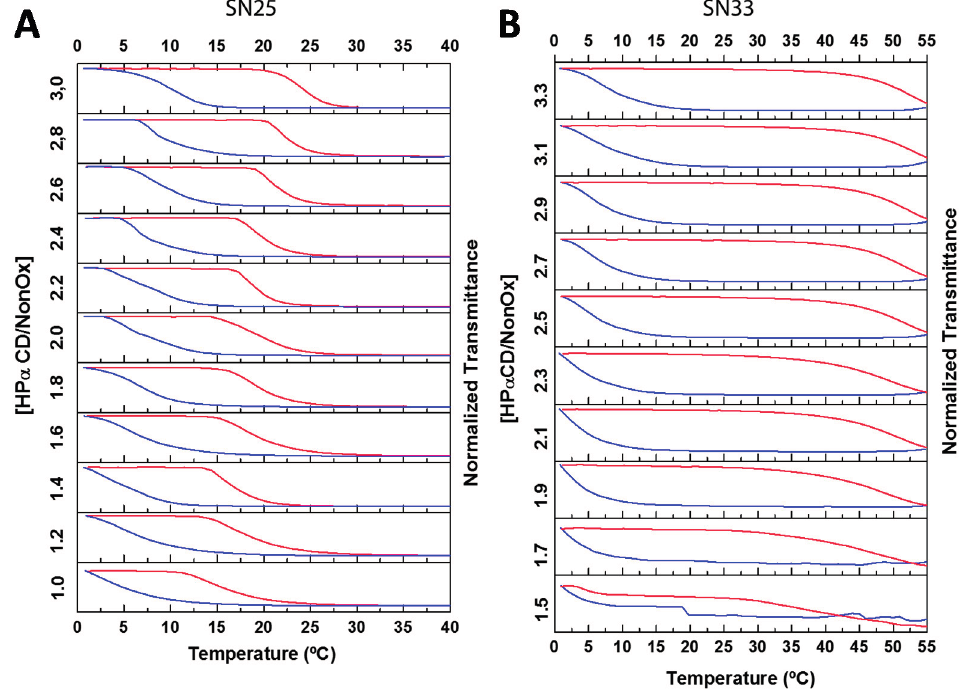
Figure 7. Turbidimetry studies of of 5 mg·mL − 1 solutions of P[(EtOx) 75 - ran -(NonOx) 25 ] ( A , SN25) and P[(EtOx) 62 - ran -(NonOx) 29 ] ( B , SN33) with increasing HP α CD/NonOx molar ratios. Both copolymers exhibited minor variations of the T CP upon addition of increasing amounts of cavitand, which is ascribed to nanoparticle formation where the nonyl chains are isolated from the aqueous environment. In the case of SN33, an unprecedented large hysteresis of 40 °C was found. The heating and cooling ramps are represented by the top (red) and bottom (blue) curves, respectively. Rate: 1 K·min − 1 , λ = 700